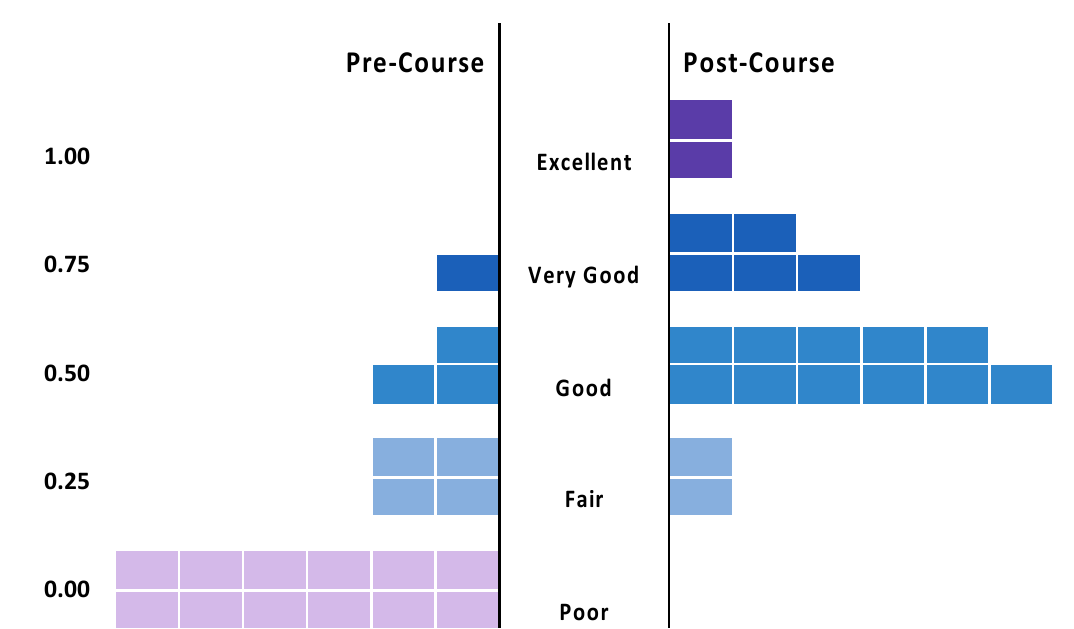
Figure 2. Performance-based Knowledge Gains-Insect Survey. Mean proportion of flower-visiting insects observed by experts (dark) and students (light) during a post-course, paired, insect survey at the Lady Bird Johnson Wildflower Center. Proportional abundance of ( A ) flower-visiting insect groups and ( B ) bee groups (see Supplementary Table S4).